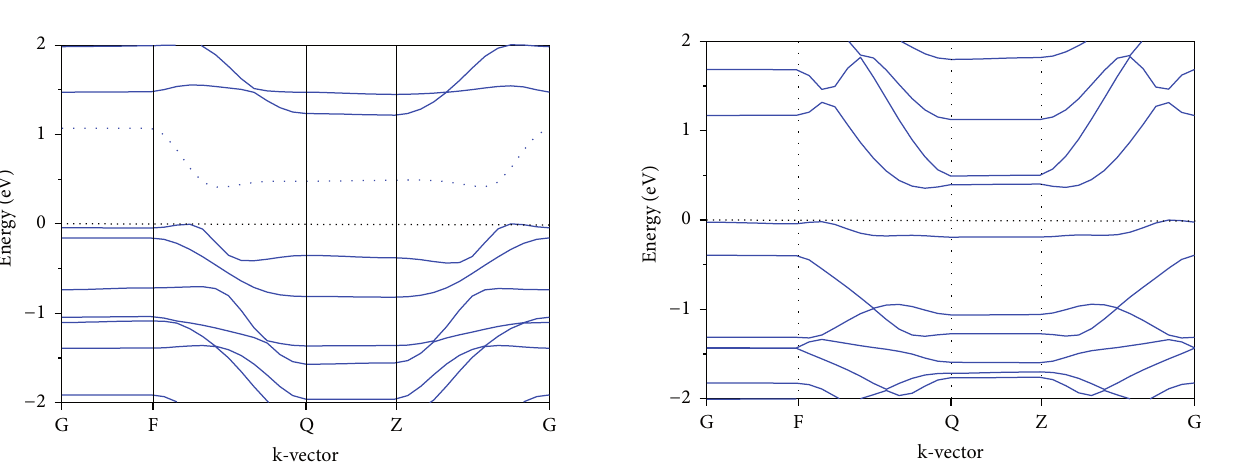
Figure 7: The electronic band structure of N1-doped single walled zigzag (5,0) BNT. The Fermi level is set corresponding to zero energy and represented by dotted line.